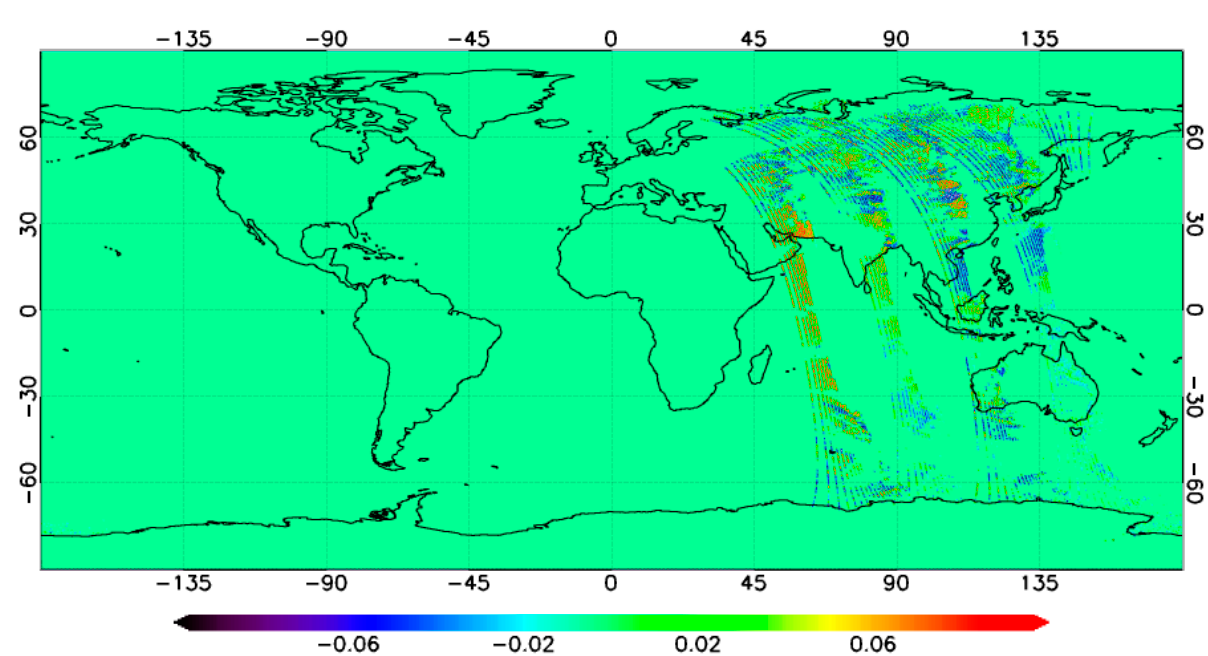
Figure 9. The total ozone amount in Dobson Unit difference between the two absolute differences (see Equation (10)). Ana represents the ECMWF analysis and 6 hF is the ECMWF 6-h forecast. “New” is the OMPS NM radiance assimilation. The unit is the Dobson Unit.